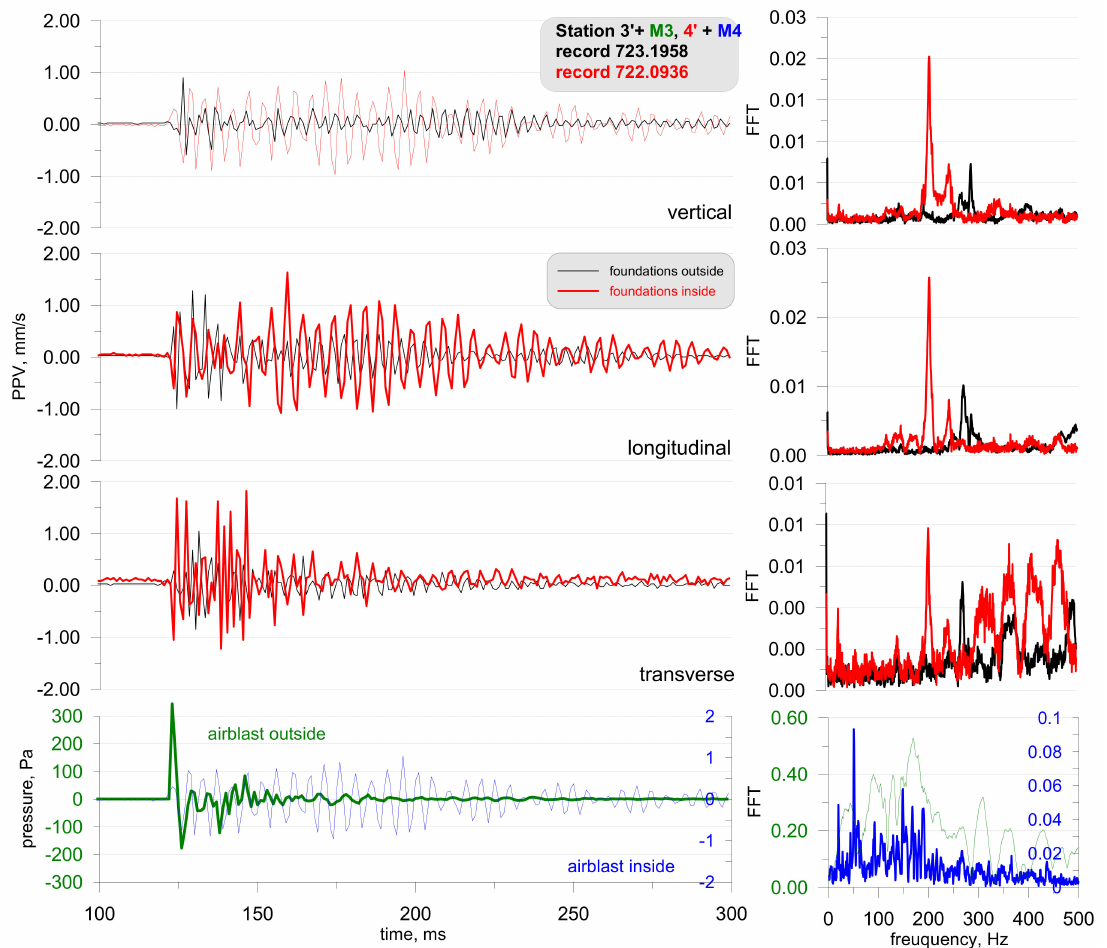
Figure 19. Foundation vibration seismogram (three directional components) and recordings of airblast wave pressure combined with the analysis of the FFT-Station 3 and